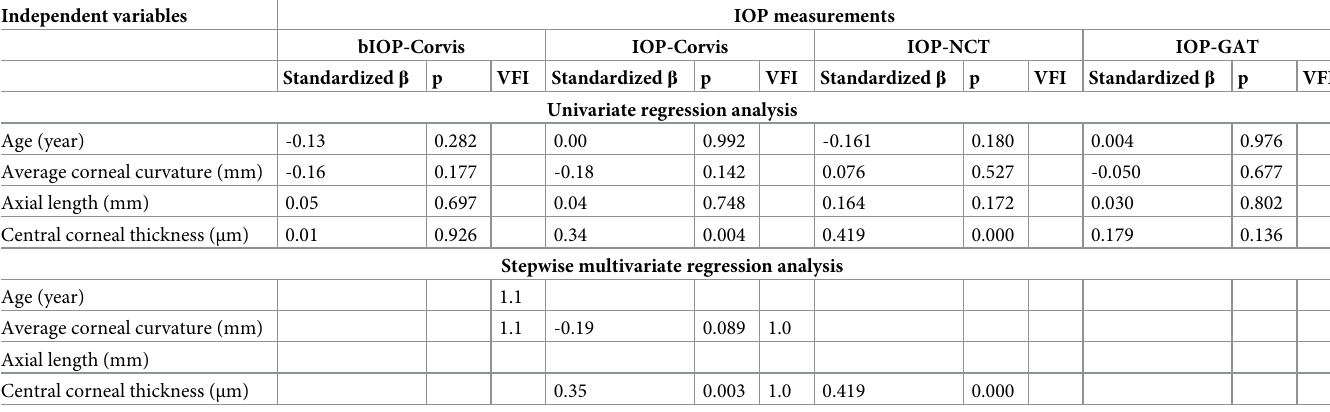
Table 2. Factors independently associated with IOP measurements in the univariate and multiple regression analyses.